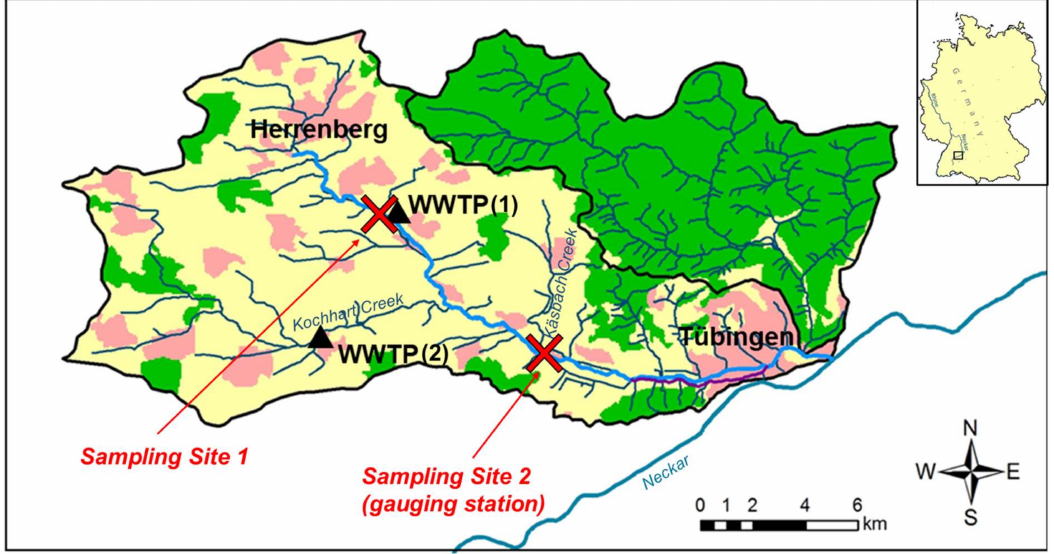
Figure 1. The Ammer catchment, its land use (pink—urban, yellow—agriculture, green—forest), and sampling locations (red crosses) in the Ammer main stem. The upstream sampling site 1 is located about 200 m upstream of the WWTP, whereas the downstream sampling site 2 is located at the gauging station (Pfä ffi